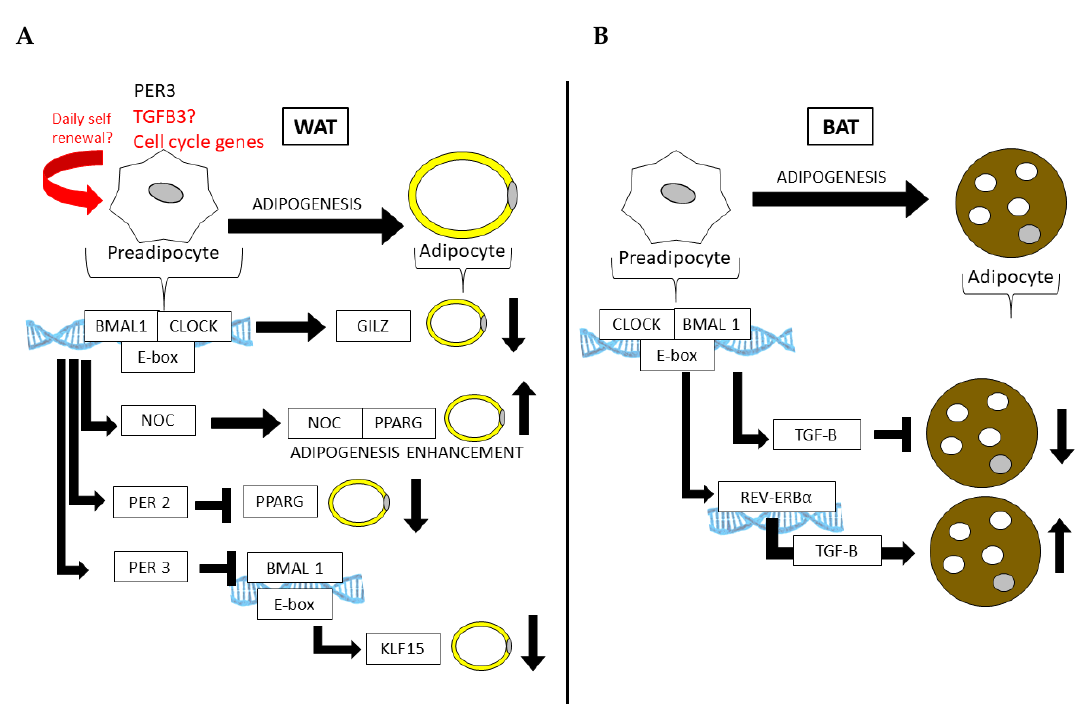
Figure 3. Core clock genes control adipogenesis in both ( A ) WAT and ( B ) BAT. In WAT, the core clock regulates genes that repress differentiation ( Gilz ) or promote the fate of a mature adipocyte ( Pparg ). Similarly, the CLOCK:BMAL1 regulation of Per3 in APCs can prevent adipogenesis in WAT by the subsequent and direct downregulation Klf15 by PER3 and BMAL1 at the Klf15 locus.